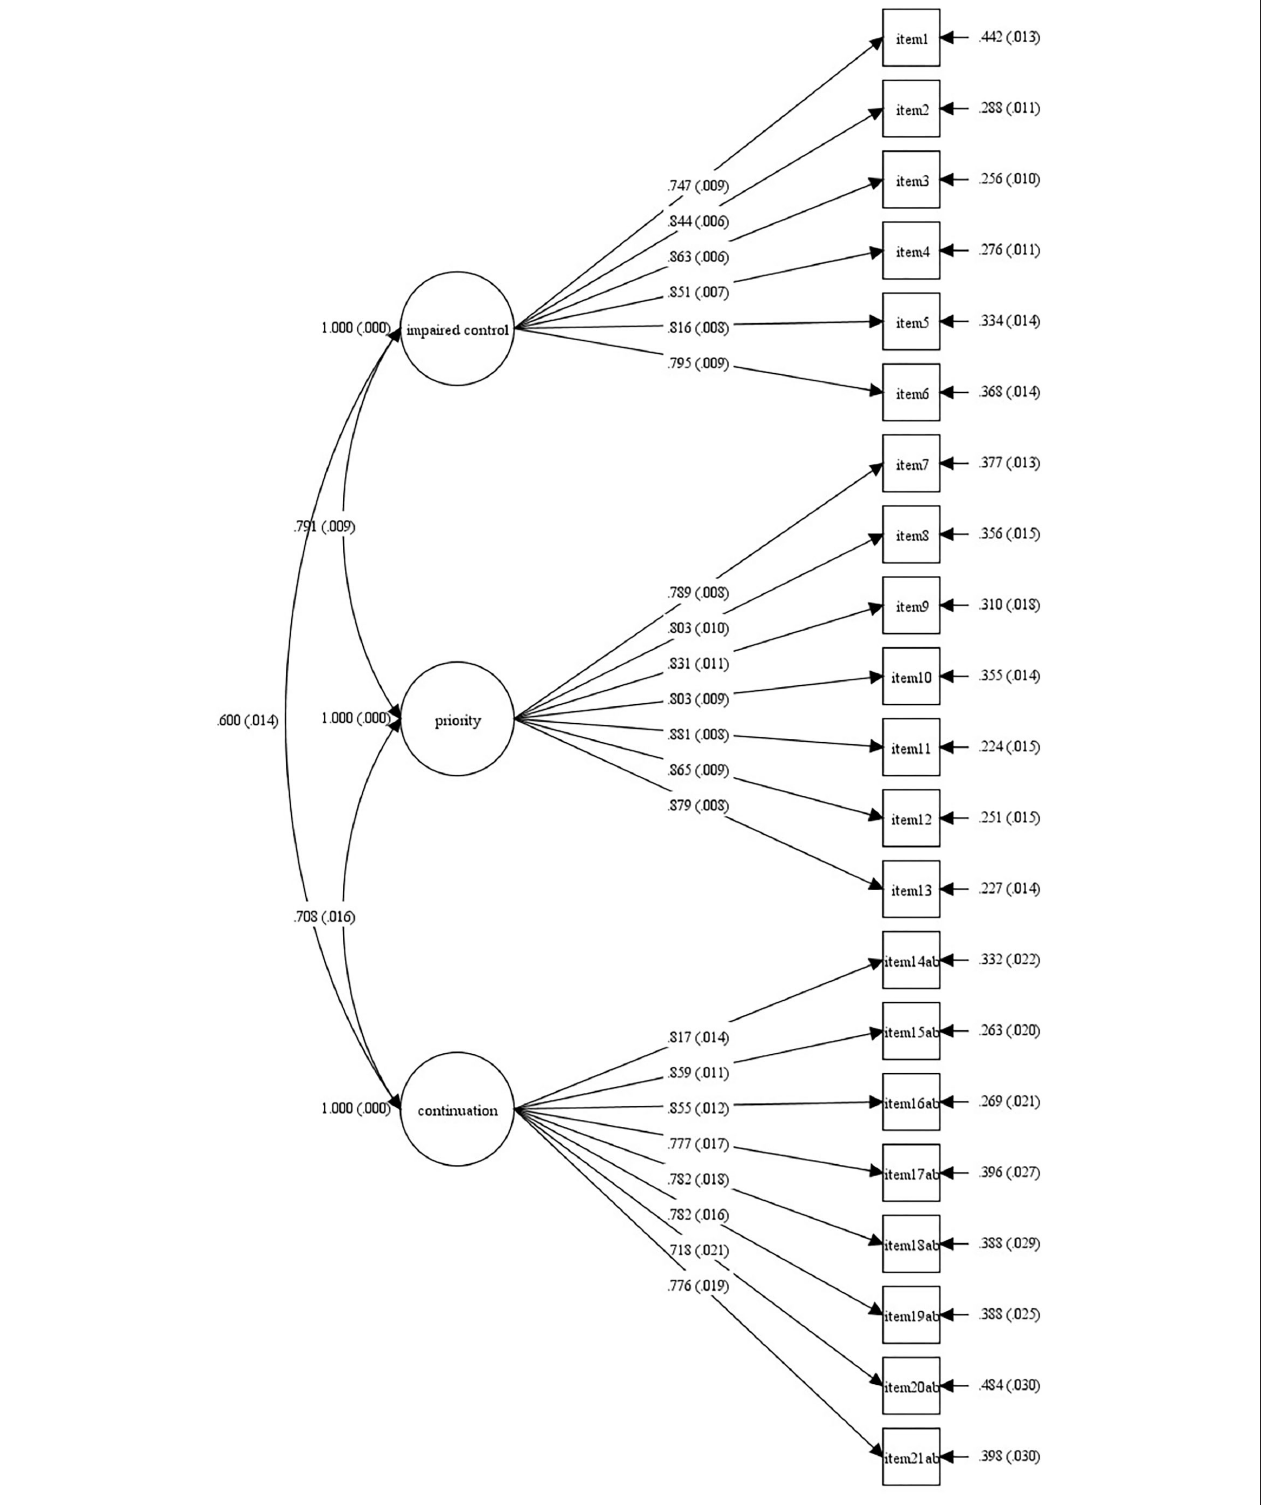
FIGURE 1 | Graphical summary of CFA results obtained from the 21 items of the GDSQ-21 ( N = 3,919). GDSQ-21, Gaming Disorder Symptom Questionnaire-21; CFA, confirmatory factor analysis.